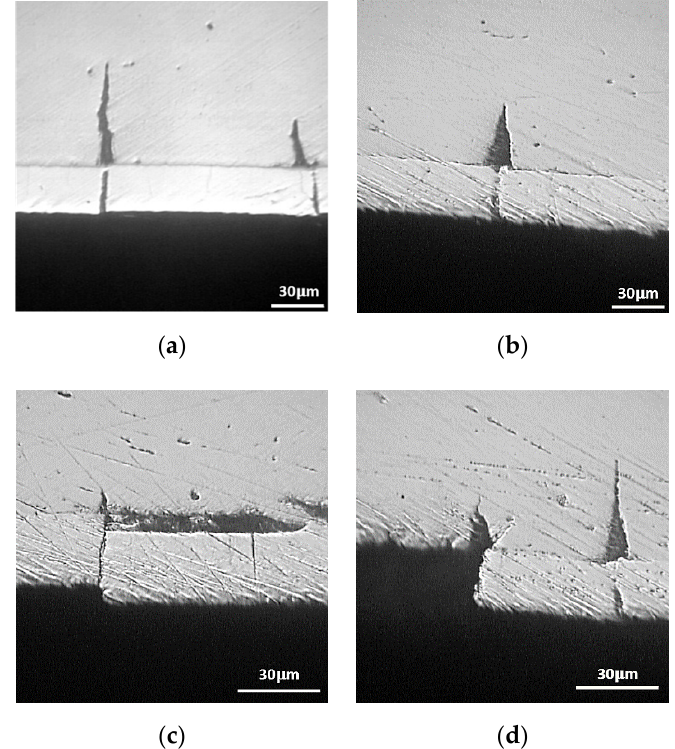
Figure 1. SEM scans of a cross-section through the wall of a 30HN2MFA steel barrel covered with a layer of chromium (JEOL 5400 scanning electron microscope): ( a , b ) cracking of steel substrate and chromium layer; ( c , d ) detachment of chromium layer [13].